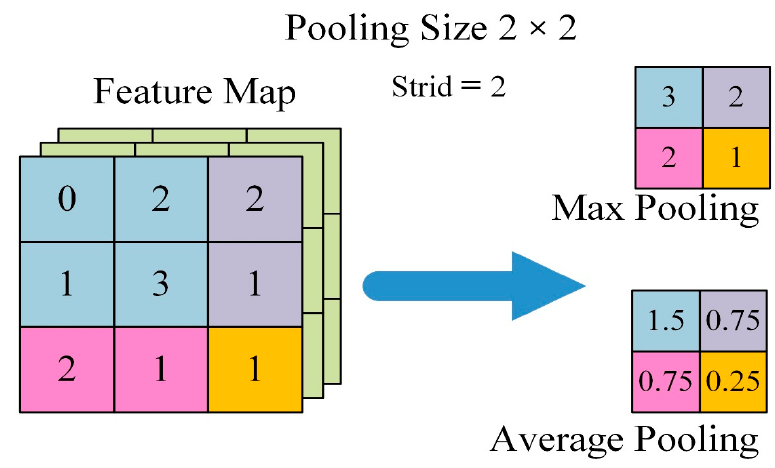
Figure 13. Schematic for the pooling operation process.